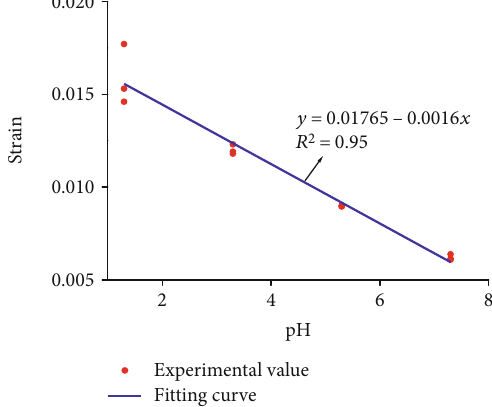
Figure 7: Variation trend of peak strain with pH.